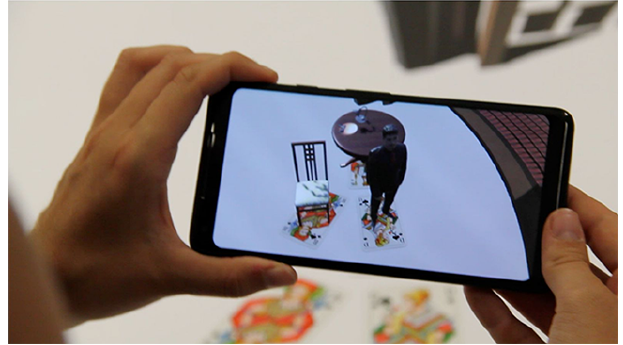
Figure 14. The AR scene design prototype running on a smartphone. The cards presents assets.